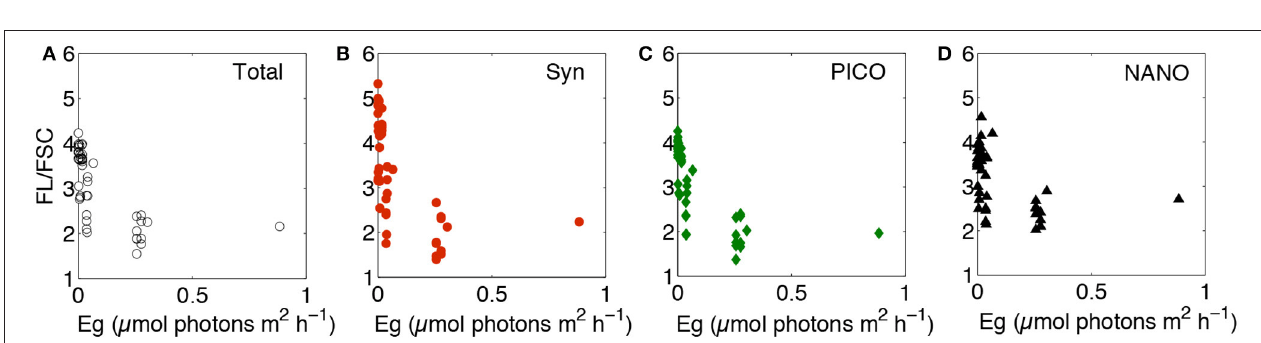
FIGURE 9 | Mean fluorescence per forward scatter ratios plotted against growth irradiance (Eg) for (A) total community, (B) Synechococcus , (C) picophytoplankton, and (D) nanophytoplankton. Eg calculated using MLDs from density gradient approach. Data only includes samples from within the euphotic zone, i.e., where Eg > 1% surface